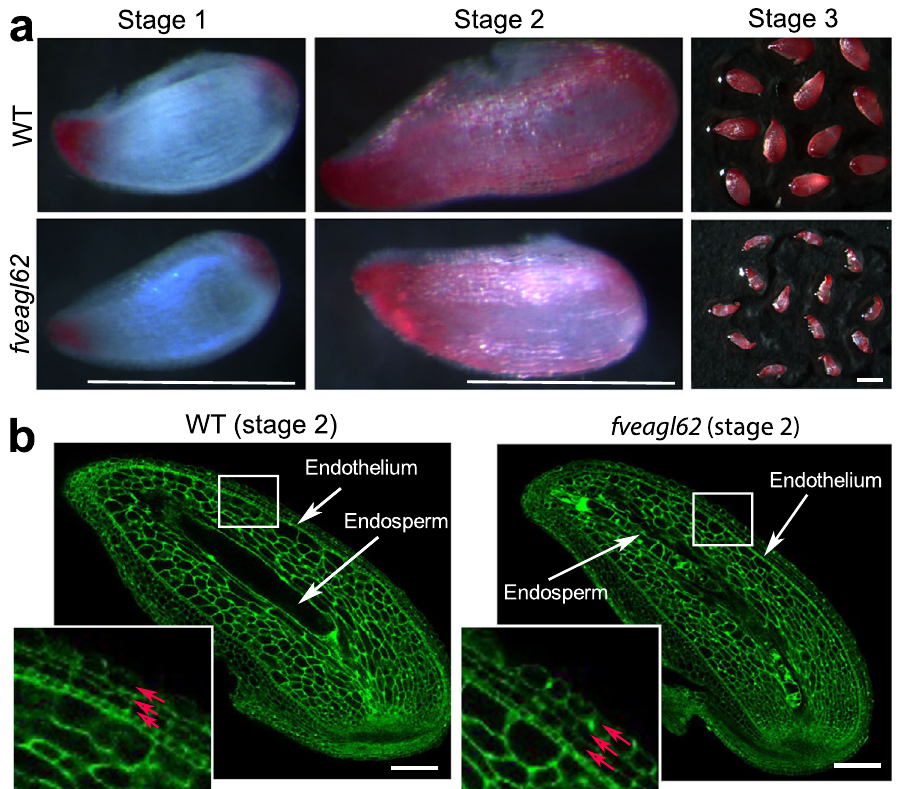
Fig. 4 Characterization of F. vesca fveagl62 mutant seedcoat. a Vanillin-stained F. vesca WT and fveagl62 mutant seeds at the pre-fertilization stage 1 and post-fertilization stages 2 – 3. The proanthocyanidins in the endothelium layer stains red with the vanillin. b Confocal laser scanning microscopy images of WT and fveagl62 seeds at stage 2. The enlarged box highlights the three integument cell layers (red arrows) exterior to the endothelium. Scale bars, 500 μ m ( a ), 100 μ m ( b